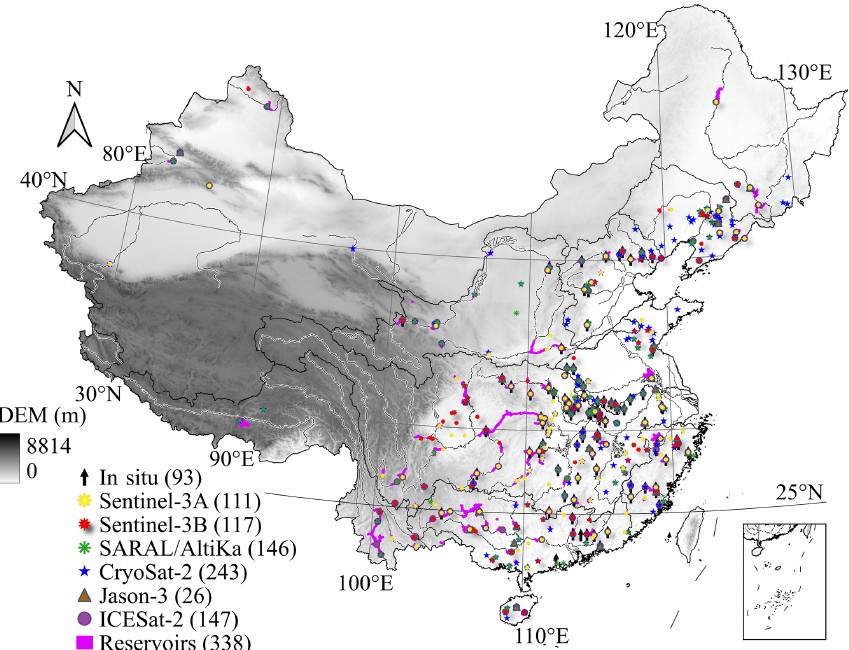
Figure 1. Map of the reservoirs covered by multiple source satellite altimeters and stages. A total of 338 reservoirs are finally retained in our datasets. For more details, please refer to Sect. 3. Table 2. Summary of altimetry datasets used in this study. Satellite Data period Retrackers Repeat cycle